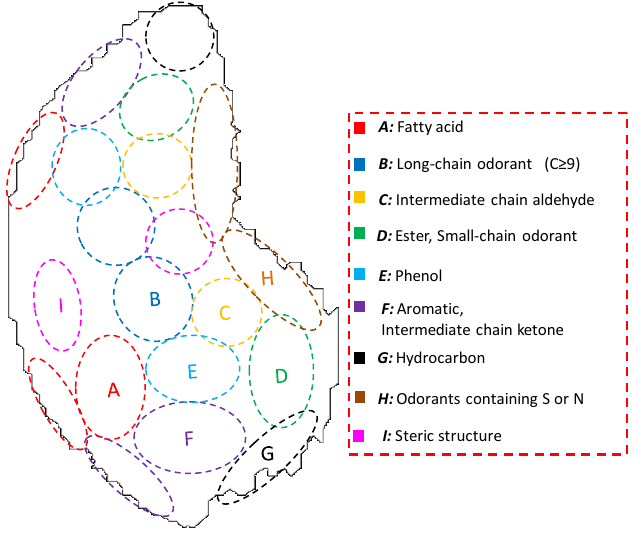
Figure 1. The illustration of odor map and the geometric feature in the biological olfaction based on mapping patterns of rats in the Leon laboratory. Odorants with similar molecular structures are classified into the same